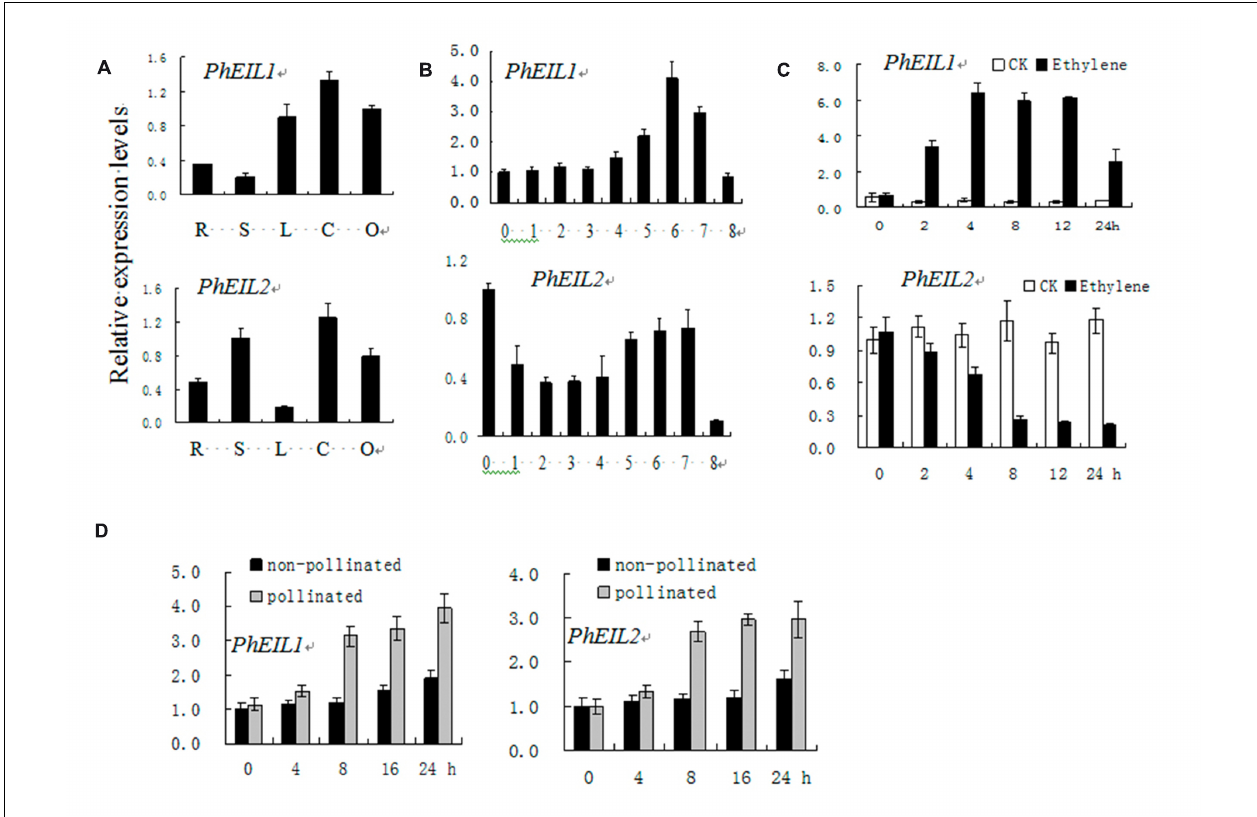
FIGURE 1 | Temporal and spatial expression analysis of PhEIL1 and PhEIL2 by quantitative real-time PCR. Expression analysis of PhEIL1 and PhEIL2 in different organs (A) , in corollas during natural flower senescence (B) , response to ethylene (C), and pollination (D) . R, roots; L, leaves; S, stems; C, corollas, O, ovaries. Relative expression levels are shown as fold change values. Data are the mean ± SD ( n = 3). Statistical analysis was performed using one way analysis of variance (ANOVA) followed by Duncan’s multiple range test (DMRT) with three replicates. P -values ≤ 0.05 were considered as significant.